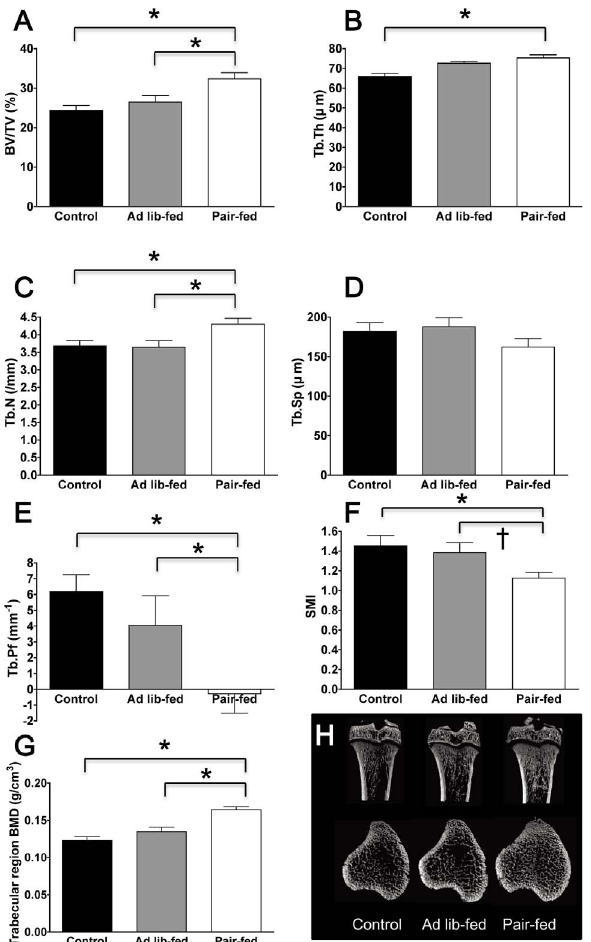
Figure 2. Effect of chronic ICV ghrelin infusion on the tibia trabecular bone phenotype. (A) Trabecular bone volume expressed as percentage of total tissue volume (BV/TV). (B) Trabecular thickness (Tb.Th). (C) Trabecular number (Tb.N). (D) Trabecular separation (Tb.Sp). (E) Trabecular pattern factor (Tb.Pf). (F) Structure model index (SMI); a lower SMI indicate plate-like structure, whereas a higher SMI indicate sphere-like structure. (G) Trabecular volumetric BMD. (H) Representative microCT images of the proximal tibia. Three groups of rats (4–6 per group) were infused for 21 days with saline or ghrelin (1.5 m g/day). Rats infused with ghrelin were ad lib -fed or pair-fed (to saline-infused rats). * P , 0.05; { P , 0.1. Data are presented as the mean 6 SEM. differences in ex vivo BMD measurements between the three groups (Table 1). Chronic ICV ghrelin infusion increases the mineral apposition rate Chronic ICV ghrelin infusion significantly increased the mineral apposition rate (MAR) in the ghrelin pair-fed group compared with the control group (5.0 6 0.2 m m/d vs. 4.0 6 0.1 m m/d, P= 0.014, Fig. 3) (ANOVA F value =5.36). The ghrelin ad lib - fed group tended to have a higher MAR compared with the control group (P= 0.073, Fig 3). No significant differences in bone formation rate were observed among the three groups.